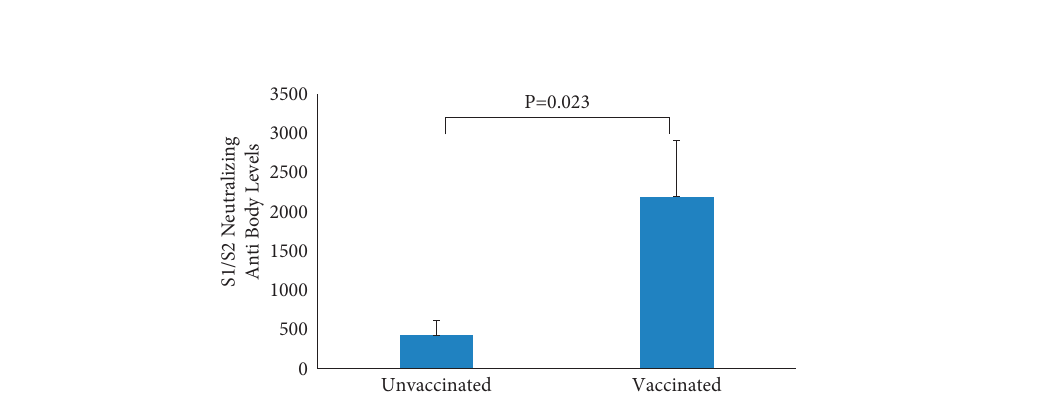
Figure 3: Comparison of S1S2 antibody titres between unvaccinated and vaccinated individuals by Student t ’ test.